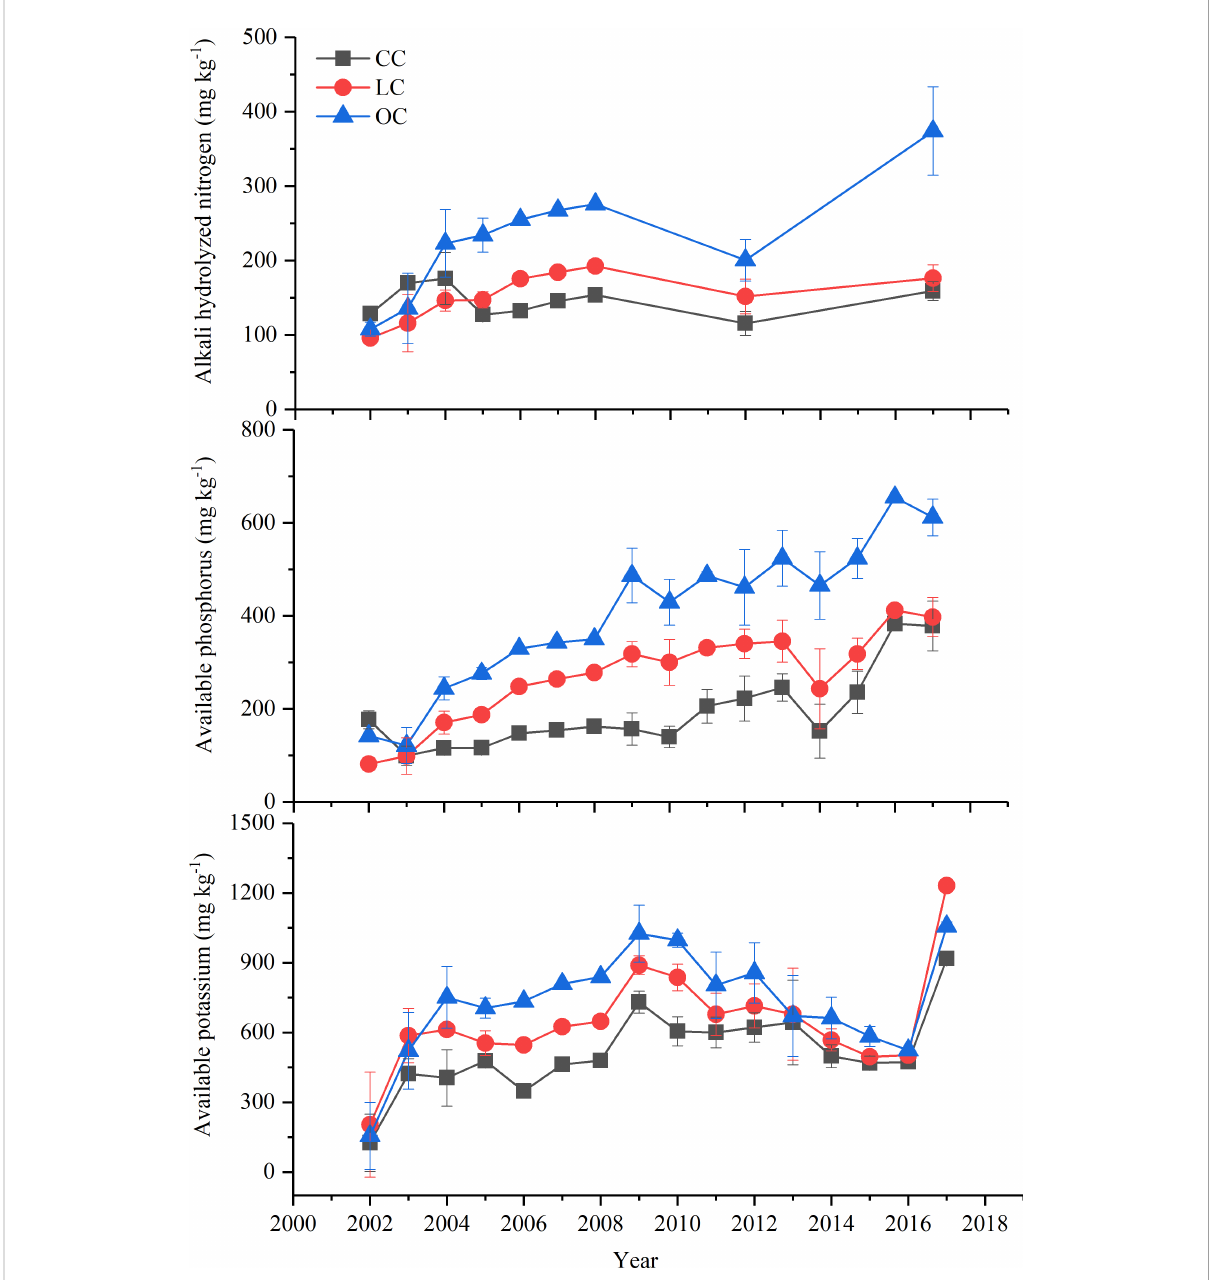
FIGURE 4 Soil available nutrient content with the three different cultivation methods from 2002 to